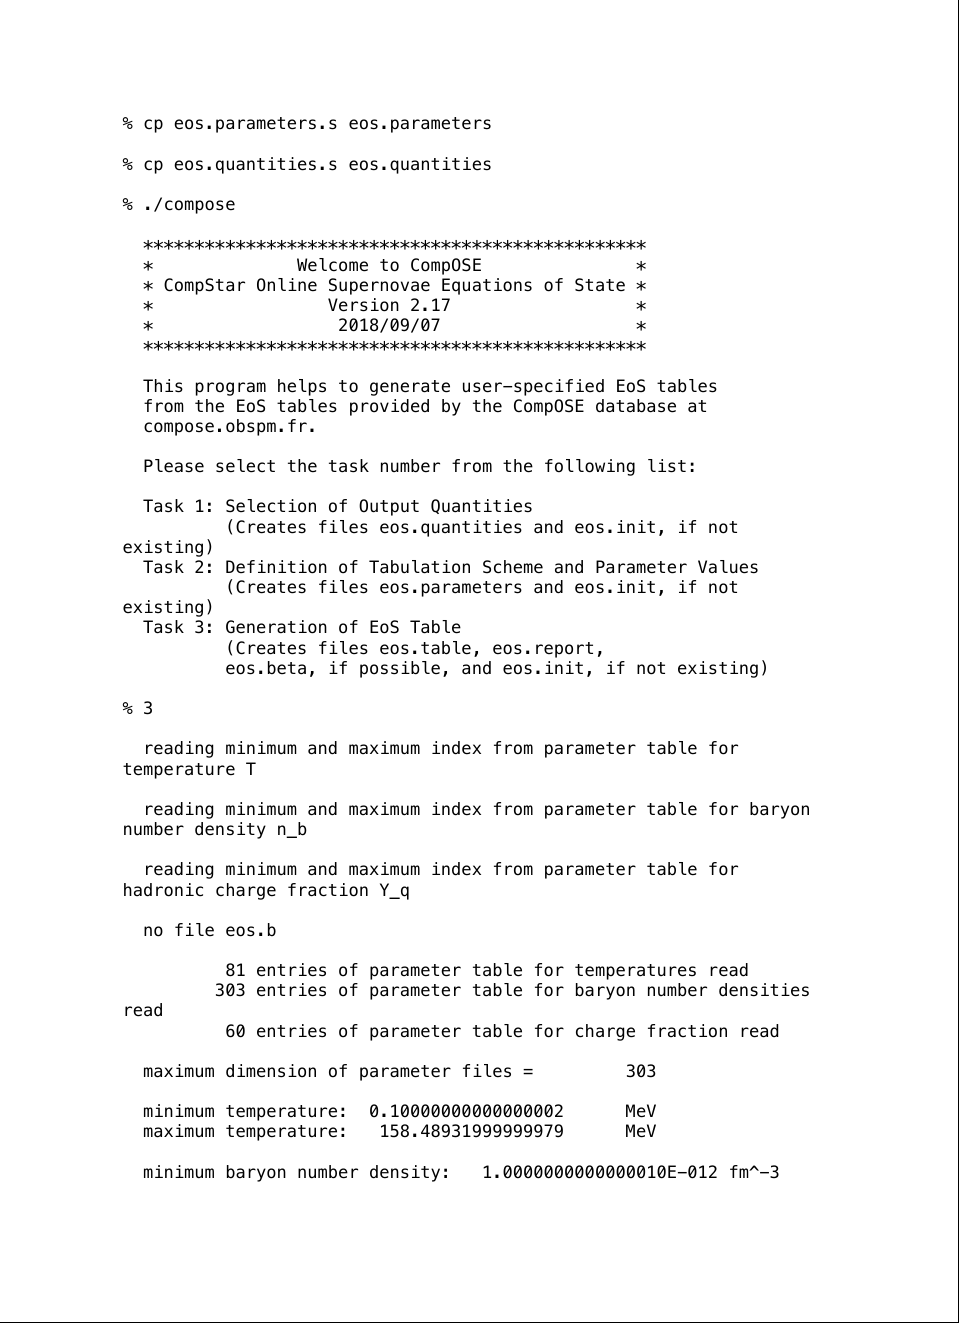
Figure A2. Snapshot when running compose for generating a table at fixed entropy per baryon from a general purpose